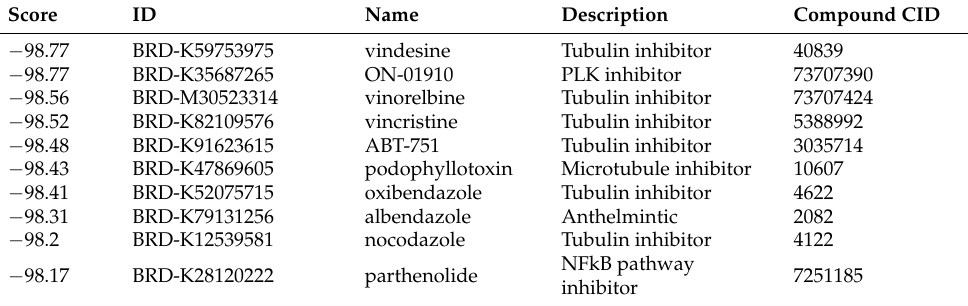
Table 2. Top 10 drugs with the highest negative correlations with the common DEGs predicted using